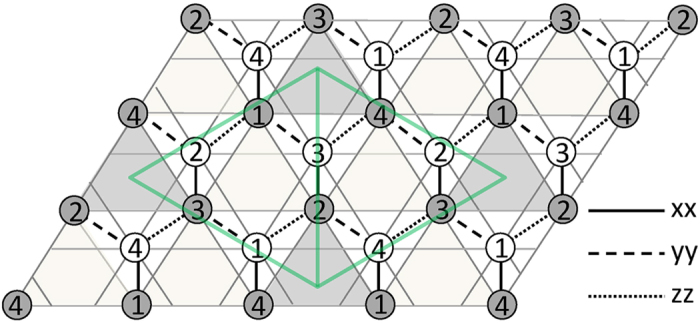
A sketch of honeycomb lattice, which is composed of two triangular sublattices as represented by white and gray dots respectively.The solid, dashed and dotted black thick lines indicate three kinds of spin-dependent nearest-neighboring bonds, where xx, yy and zz involve Sx, Sy, and Sz respectively. The gray thin lines present the links between the next nearest neighbors. Sites 1–4 specify the four sites for the spin rotations S → . The shading illustrates the upward-pointing elementary triangles of one triangular sublattice, on which the vector chirality (κ) is calculated. Dark shading denotes every third upward-pointing triangles, and the vorticity (v) is evaluated on right- and left-pointing triangular loops (green) connecting these darker triangles.